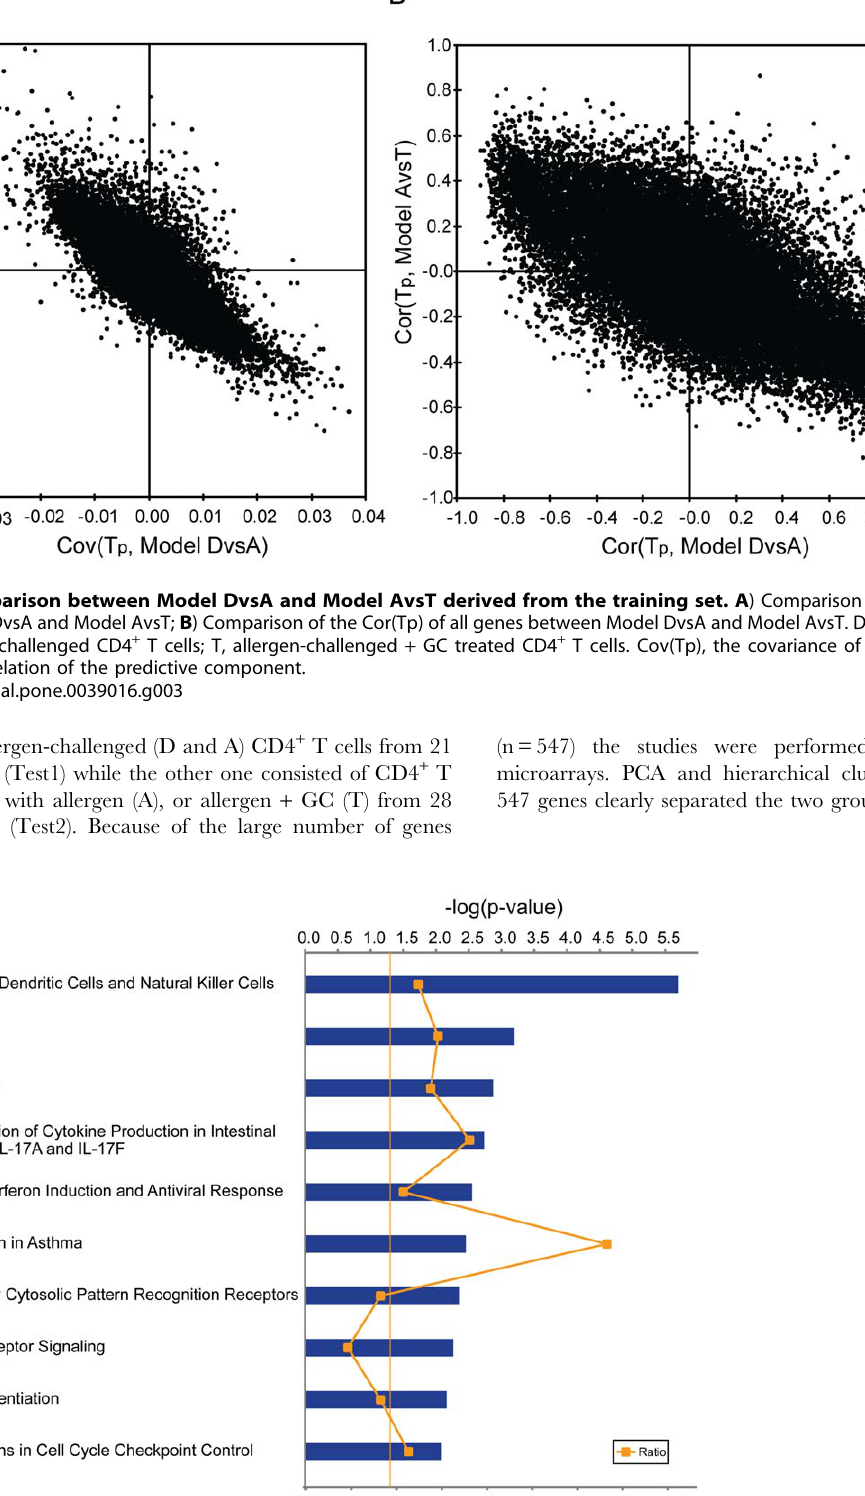
Figure 4. Pathway analysis of allergen-induced top 547 genes whose expression was reversed by glucocorticoids. The top 547 genes with a |Cor(Tp)| $ 0.5 from the two models were extracted and mapped to Ingenuity pathway analysis. The yellow threshold indicates 95% confidence.